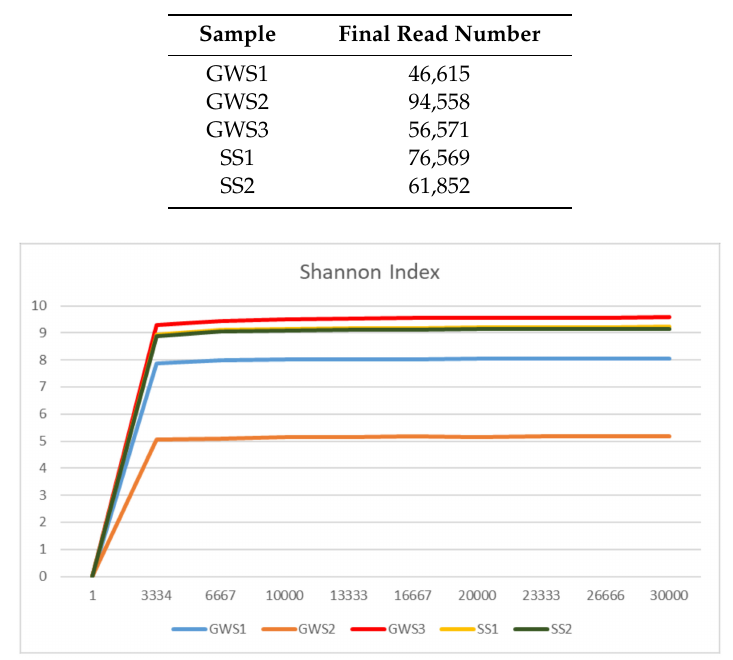
Table 1. Number of 16S rDNA sequences obtained after next-generation sequencing (NGS) analysis for groundwater and soil samples.